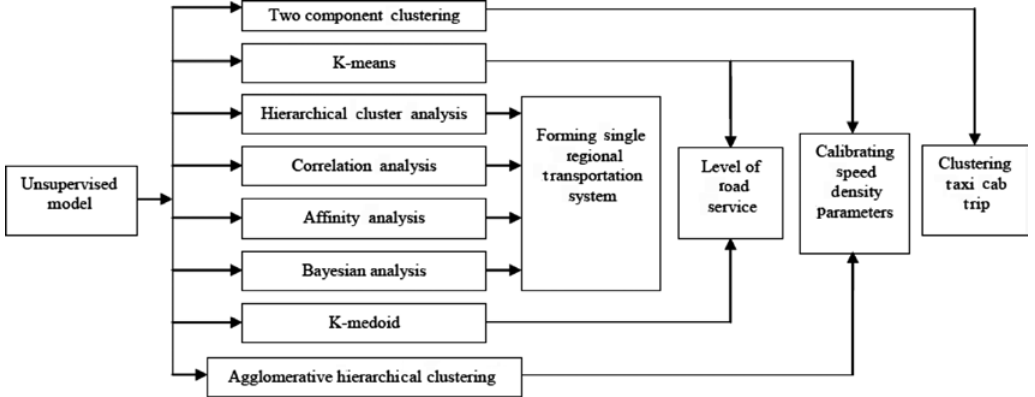
Figure 2: List of Unsupervised Models Used in Intelligent Transportation